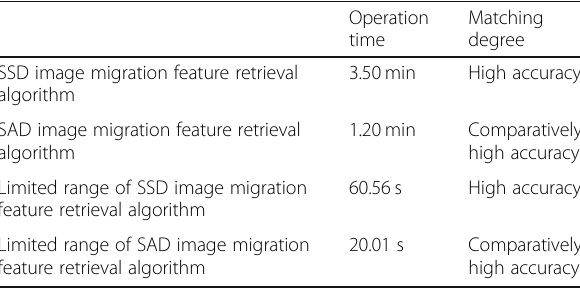
Table 1 Effect evaluation of four image matching